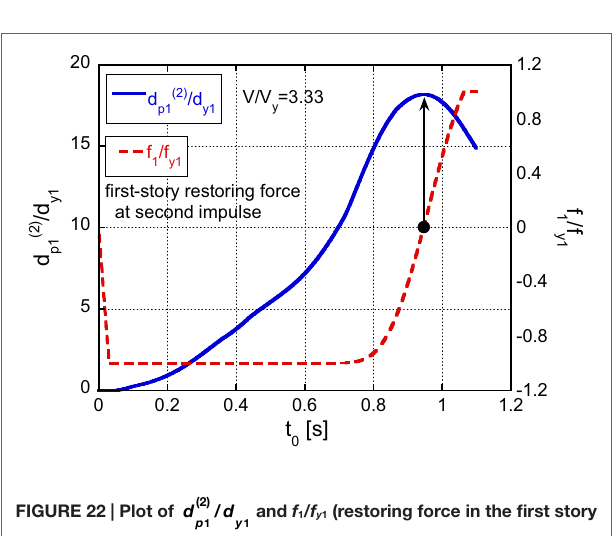
at the second impulse) with respect to the timing of the second